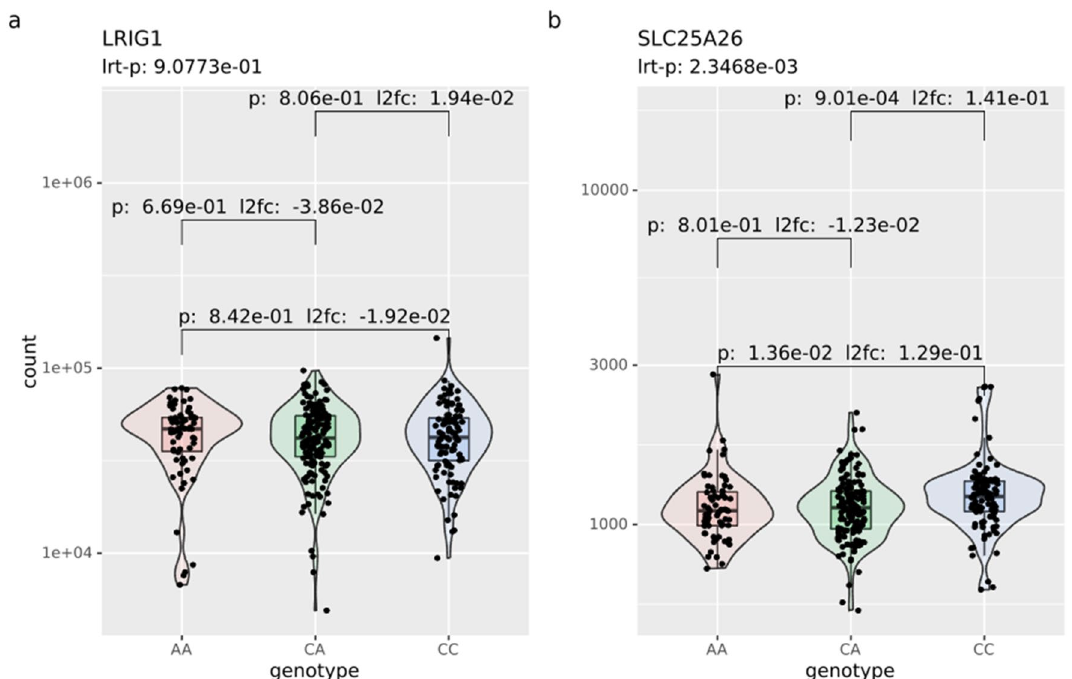
Figure 3. Expression of LRIG1 and SLC25A26 in TCGA LGG tumors. Normalized gene counts for ( a ) LRIG1 and ( b ) SLC25A26 from TCGA data for IDH-mutated low-grade gliomas. p-values using the Wald test and log- twofold count between all genotypes are shown. p-values from likelihood ratio testing across all genotypes are shown above